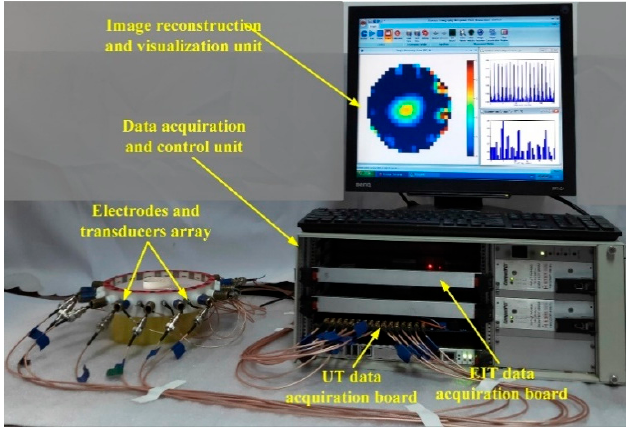
Figure 11. EIT/UT dual-modality data acquisition system.